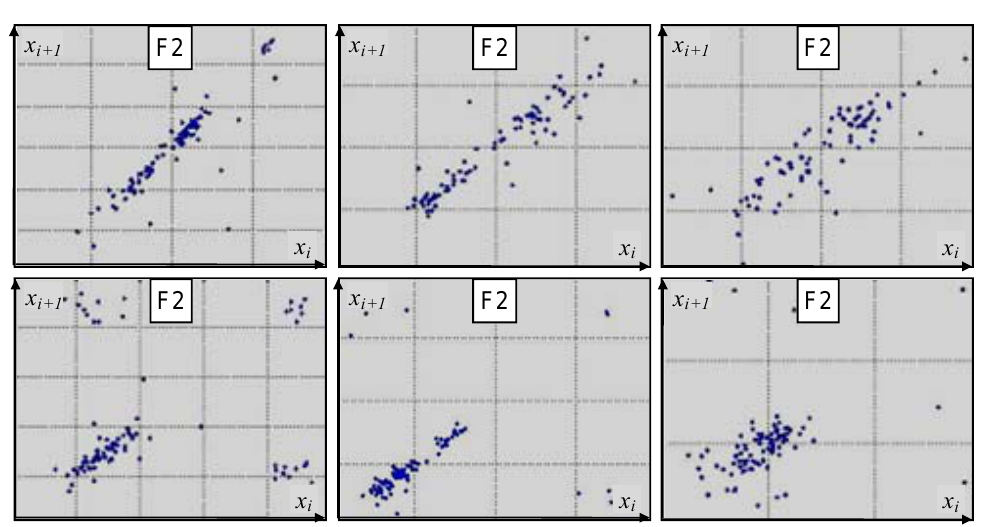
Figure 3. Poincare Maps produced for the second formant evolution for the same sentence uttered by three different speakers with two emotional loads: ‘joy’ (top row) and ‘fear’ (bottom